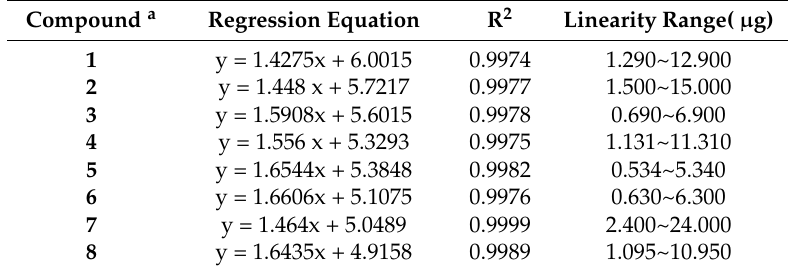
Table 3. The results of the regression equation, R 2 and linearity range of eight saponins.